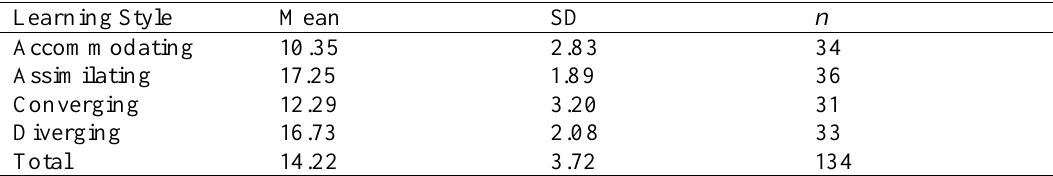
Habit Strength of Learning in Mobile